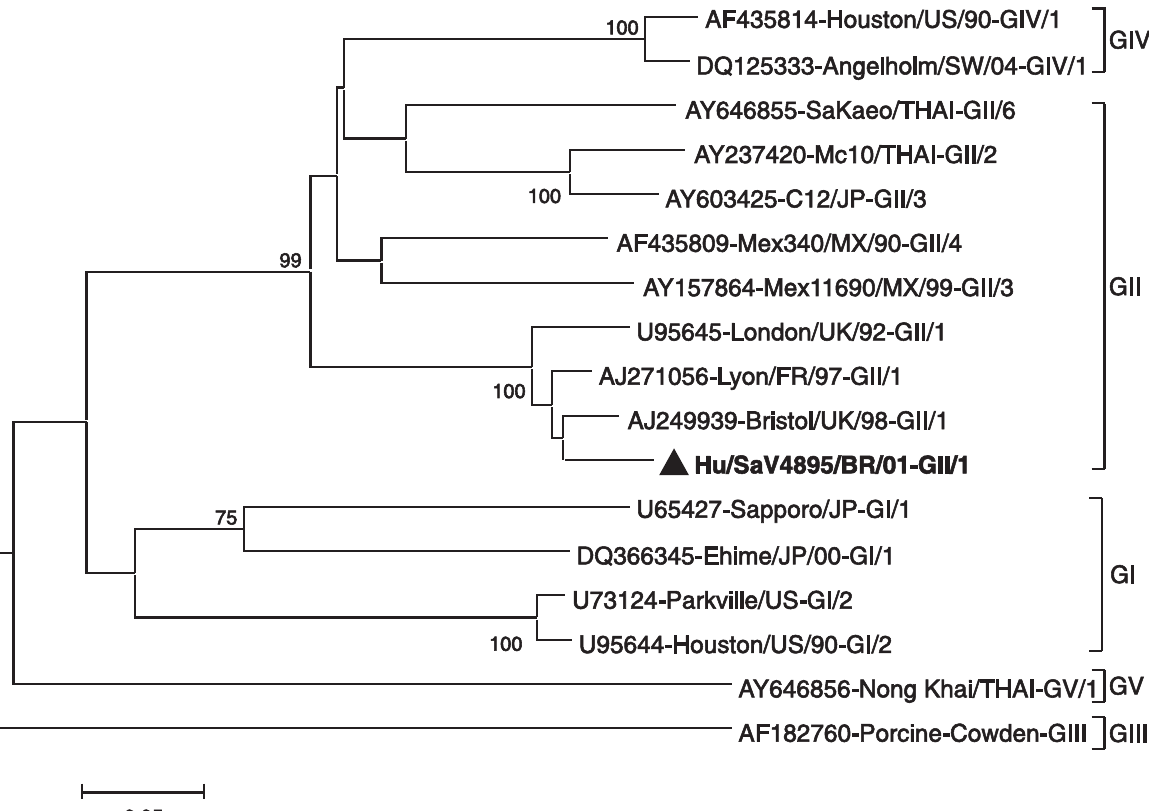
Figure 1. Phylogenetic tree of human sapovirus reference strains and Brazilian samples. Outgroup: SaV genogroup GIII